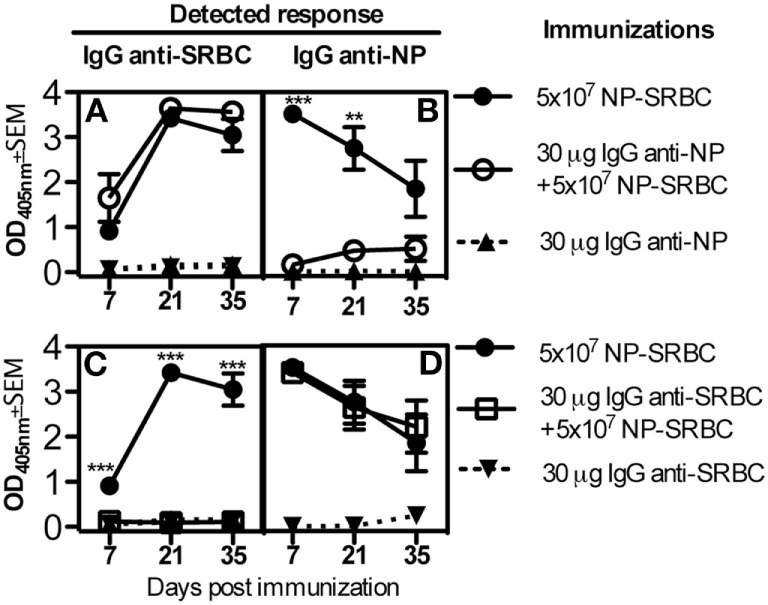
Epitope-specific suppression of IgG responses. C57BL/6 mice were immunized with 5 × 107 NP-sheep red blood cells (SRBC) ± 30 μg IgGa anti-NP or (A,B) with 5 × 107 NP-SRBC ± 30 μg IgGa anti-SRBC (C,D). IgG was also administered alone as negative control. Serum samples were diluted 1:125 and analyzed in enzyme-linked immunosorbent assay. Representative of four (A,B) or two (C,D) experiments; n = 5 mice/group (except for IgG alone where n = 2 mice/group). Statistical comparisons were done between solid circles vs. open circles in (A,B) and between solid circles vs. open squares in (C,D). ns, p > 0.05; *p < 0.05; **p < 0.01; ***p < 0.001.